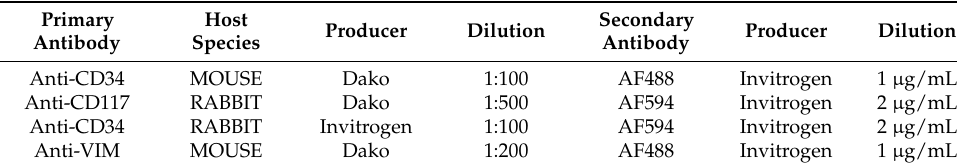
Table 2. Primary and secondary antibody used in IF and their